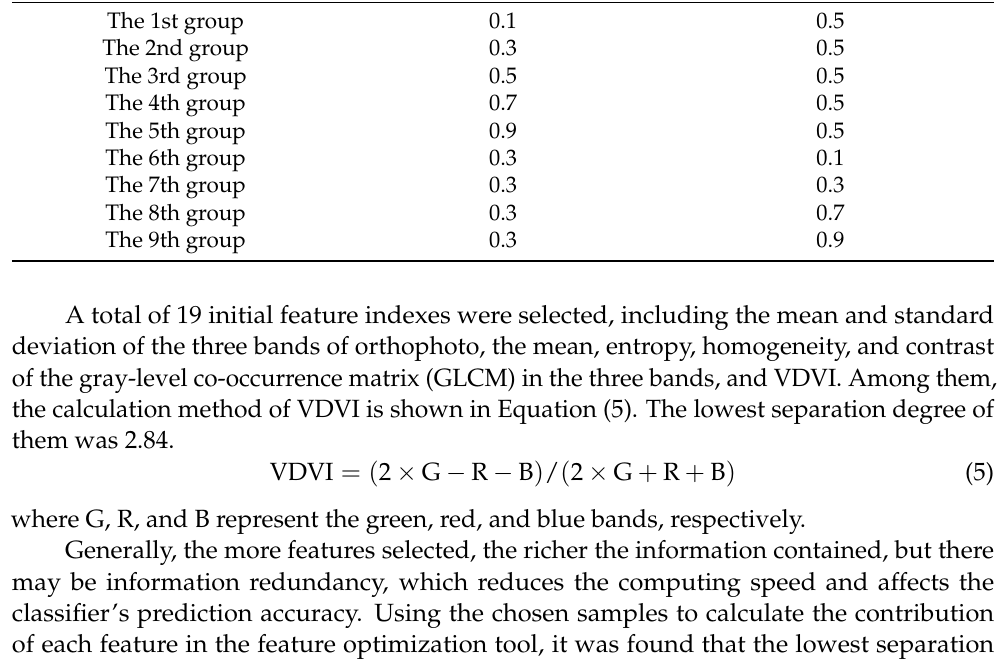
Table 1. All combinations of heterogeneous factors tested by trial and error method. Visual interpre- tation showed that the segmentation quality of the second group was the best. Shape Factor Compactness